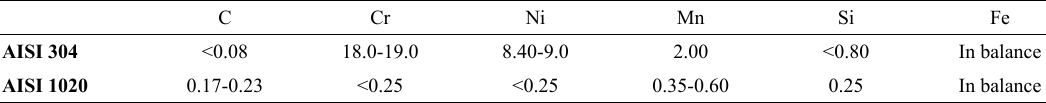
Table 1. Chemical compositions of the AISI 304 and low alloy steel (wt.%)